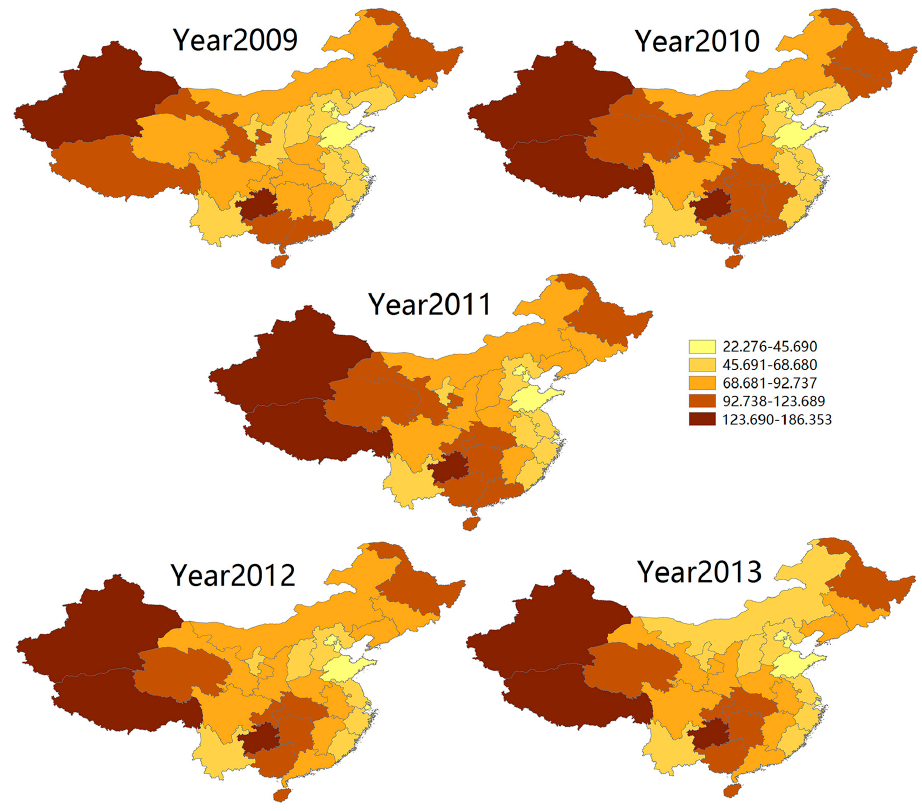
Figure 2. Spatial distribution of morbidity associated with tuberculosis in mainland China, 2009–2013.